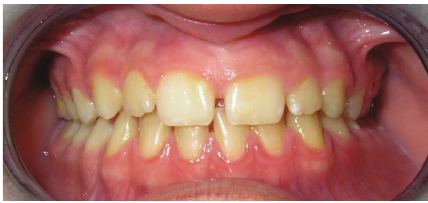
Figure 7: 8-year follow-up intraoral